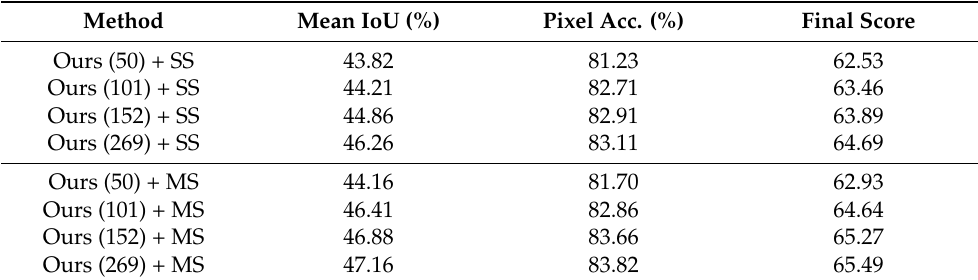
Table 1. Deeper pre-trained ResNet attains higher performance. Numbers in the parentheses refer to the depth of ResNet. SS and MS denote single- and multi-scale testing, respectively. Experiments are conducted on the ADE20K dataset.